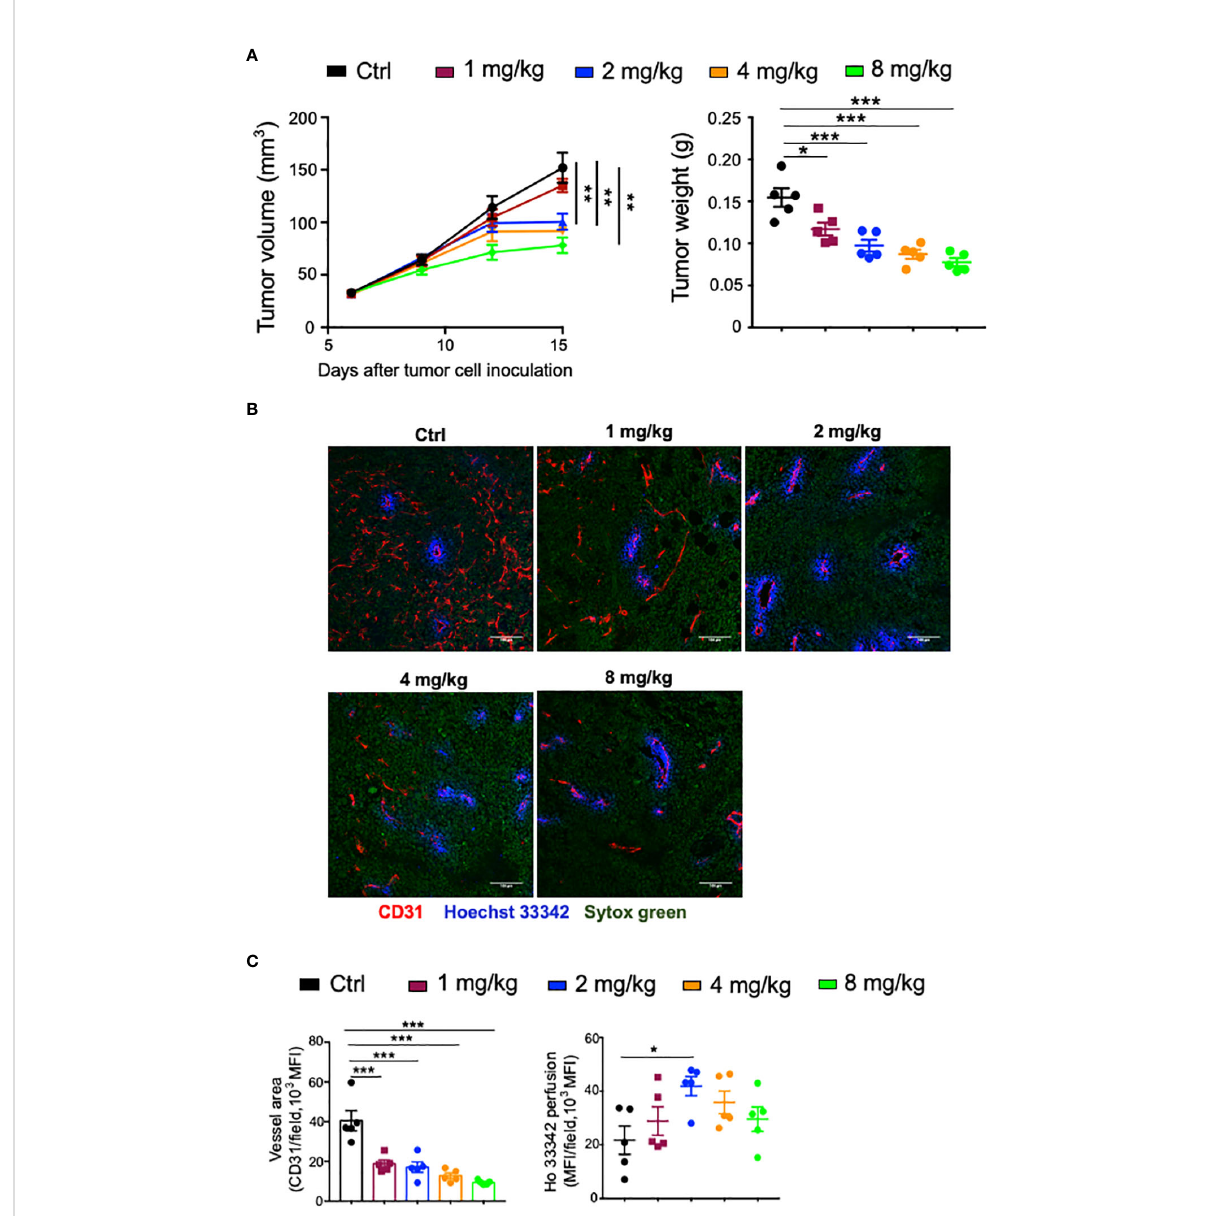
FIGURE 1 The dose effects of Anlotinib on tumor growth and vascular normalization in orthotopic EO771 breast tumor model. Female C57BL/6 mice were orthotopically inoculated with 2 × 10 5 EO771 breast tumor cells. When tumors reached 3 – 4 mm in diameter, mice were randomly grouped and administered with ddH 2 O or different doses of Anlotinib daily by oral gavage. Five minutes prior to tumor harvest, mice were intravenously injected with 200 µg/mouse Hoechst 33342 (Ho33342). Tumor size was recorded every 3 days, and tumor weight was measured at the end of the experiments. (A) Tumor growth curves and tumor weight. (B) Representative images of Ho33342 perfusion (blue) and CD31-staining (red). Scale bar = 100 µm. (C) Ho33342 perfused tumor areas and vessel density (CD31). Signi fi cance was determined by one-way ANOVA ( n = 5 mice per group). Data are presented as mean ± SEM. * p < 0.05; ** p < 0.01; *** p <